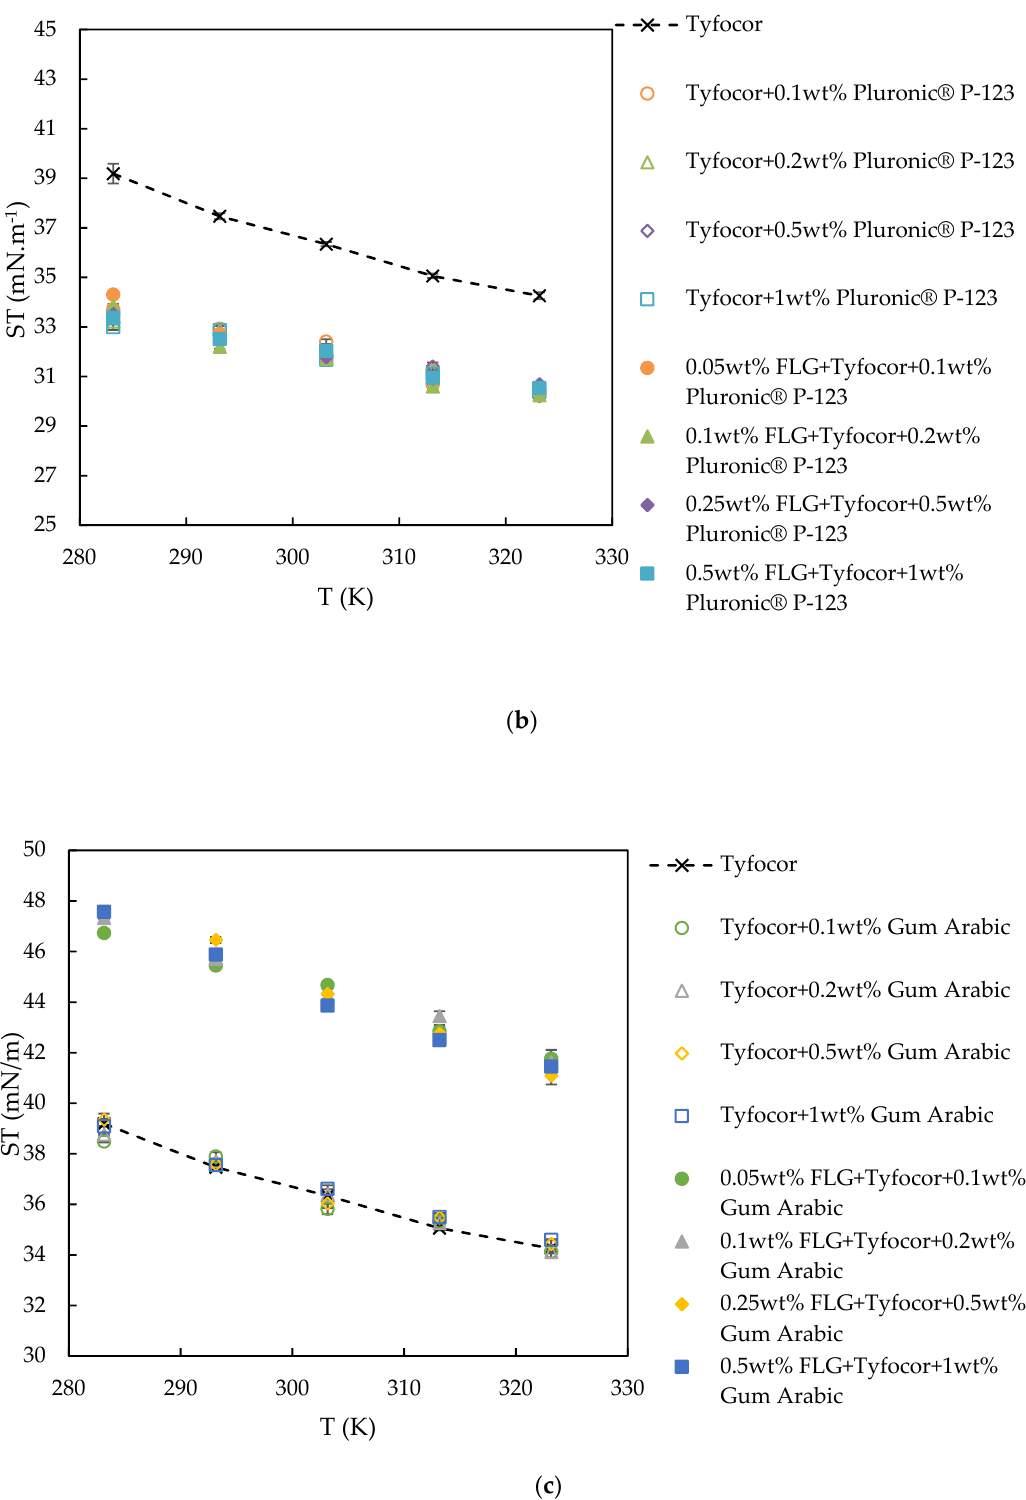
Figure 5. Evolution of surface tension (ST) of the FLG nanofluids prepared with ( a ) Triton X-100, ( b ) Pluronic ® P-123 and ( c ) Gum Arabic as a function of temperature. Dashed lines are drawn to guide the eyes.